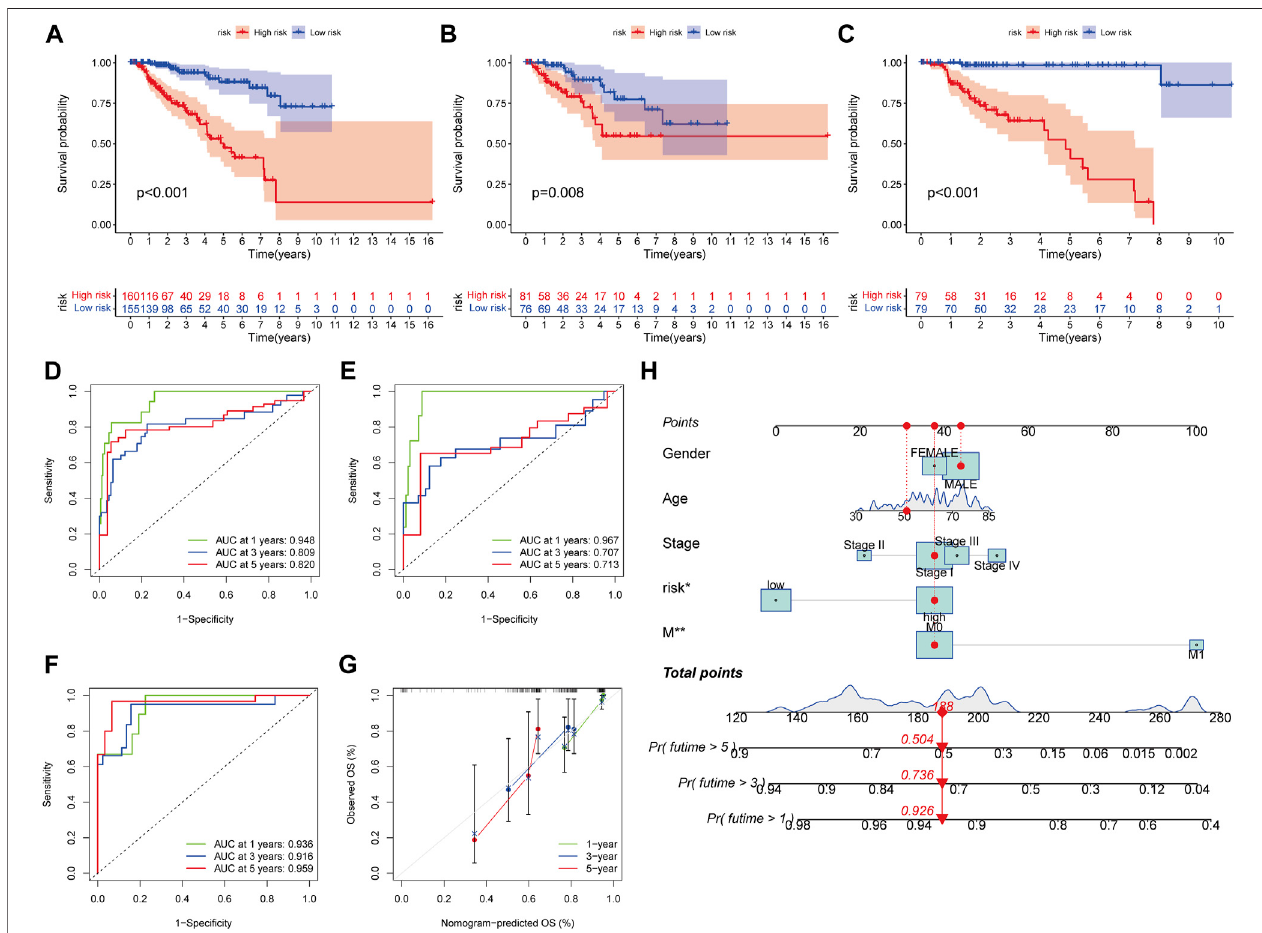
FIGURE7| Survivalprediction and nomogram. (A – C) Kaplan-Meier analysisoftheOSbetween thegroups in theoverall, training, testing, sets. (D – F) ROCcurves toestimatethesensitivityandspeci fi cityof1-,3-,and 5-yearsurvivalbasedonthePRGscoreintheoverall,training, testing sets. (G) Calibration plotsfornomogramsto predict OS at 1-, 3- and 5-year. (H) Nomogram for predicting the 1-, 3-, and 5-year OS of KIRP patients.